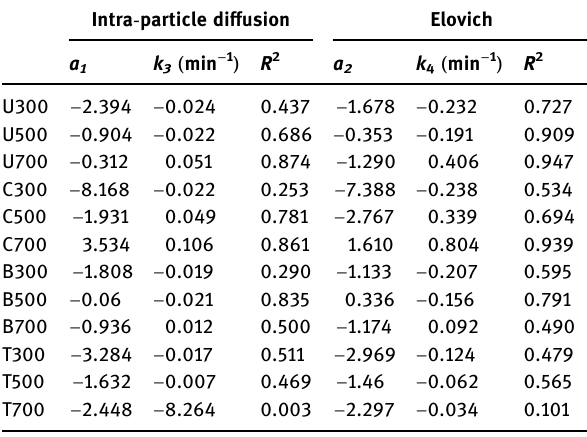
Table 3: Intra - particle di ff usion and Elovich kinetic fi tting